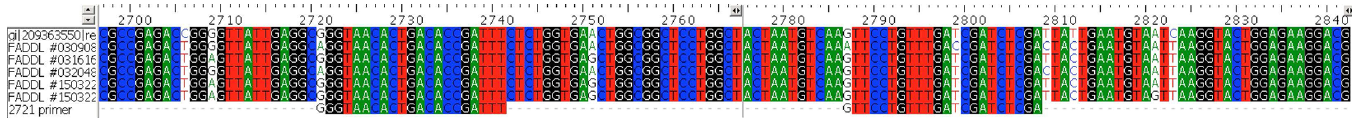
Fig 7. Sequence alignment of qRT-PCR viral isolates to SVV-001 and qRT-PCR primers. Five viral isolates were confirmed positive by qRT-PCR and the genome was sequenced. The amplification region was aligned with the qRT-PCR SV-A primers used in the assay, and to the reference sequence SVV- 001: NC_011349.1